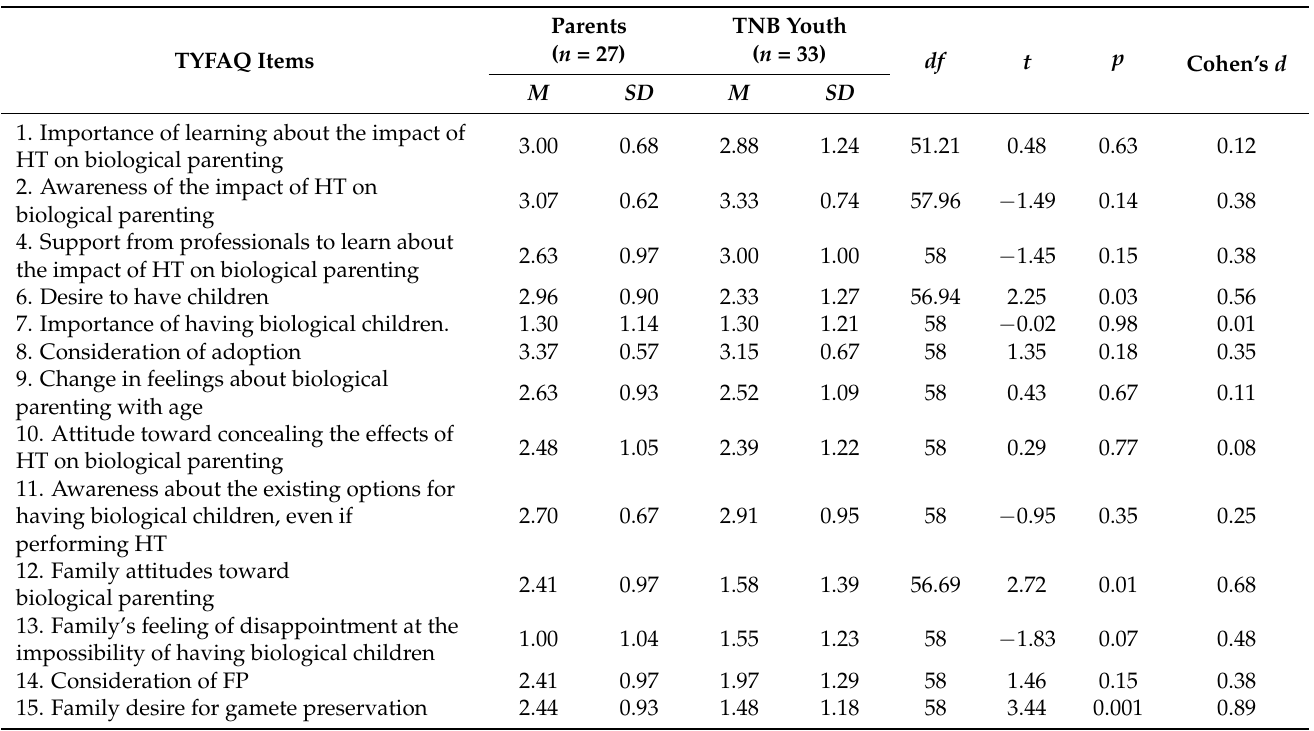
Table 2. Differences in Attitudes Towards Parenthood and Fertility Preservation between TNB Youth and Parents of TNB